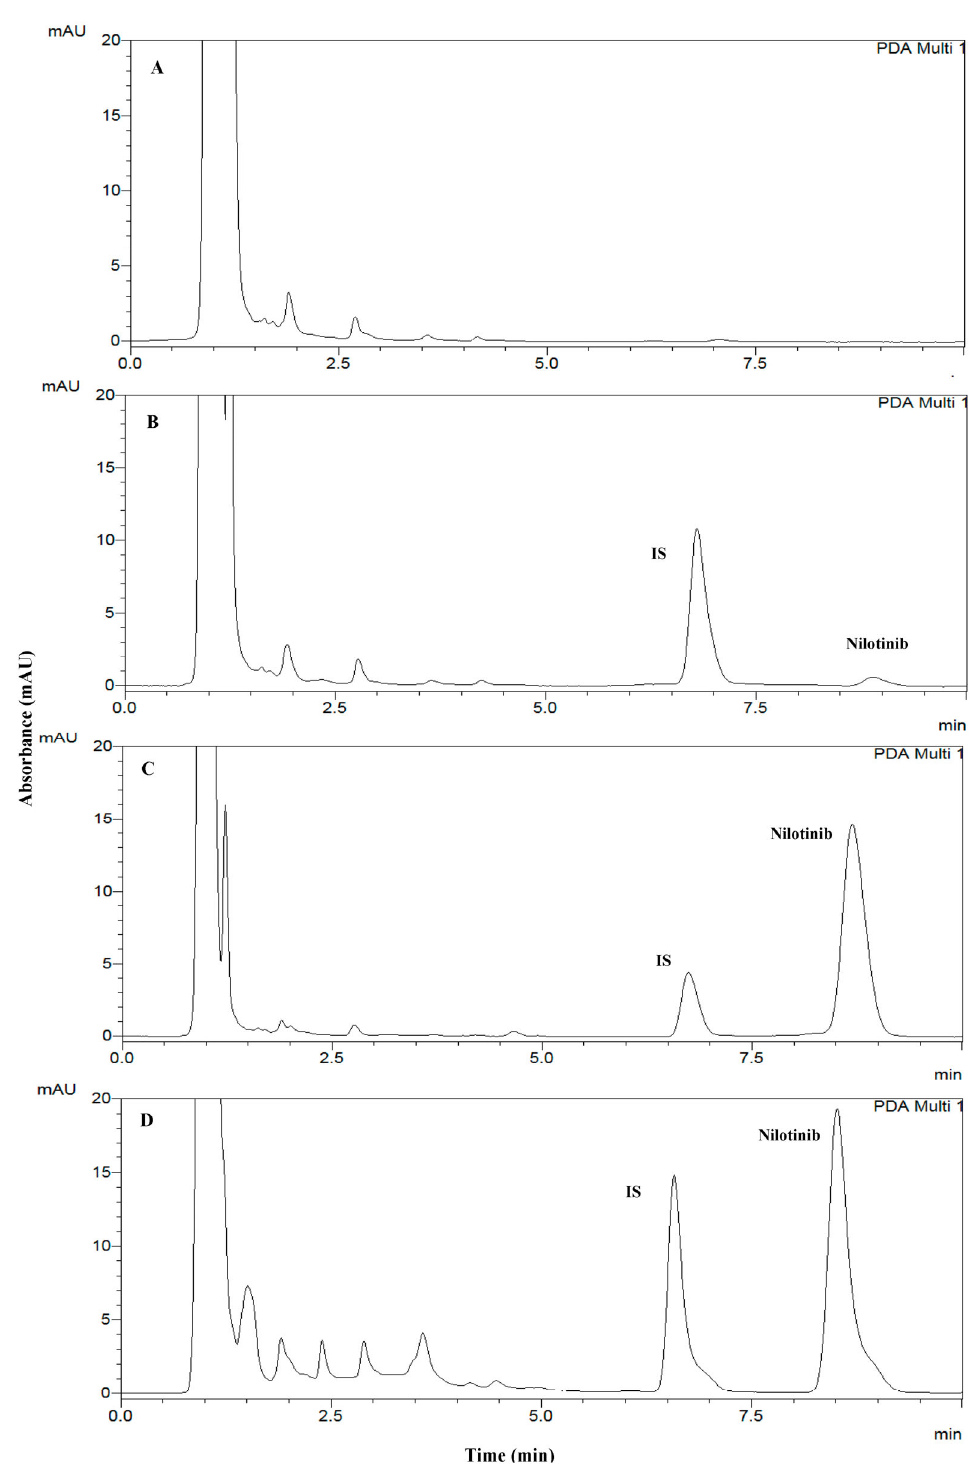
Figure 1. Representative chromatograms: ( A ) blank human plasma without nilotinib, ( B ) blank human plasma at LLOQ (125 ng/mL), ( C ) blank human plasma after addition of 7000 ng/mL of nilotinib and ( D ) a plasma simple from a patient with cancer with 300 mg of nilotinib twice a day. mAU, milliabsorbance units.